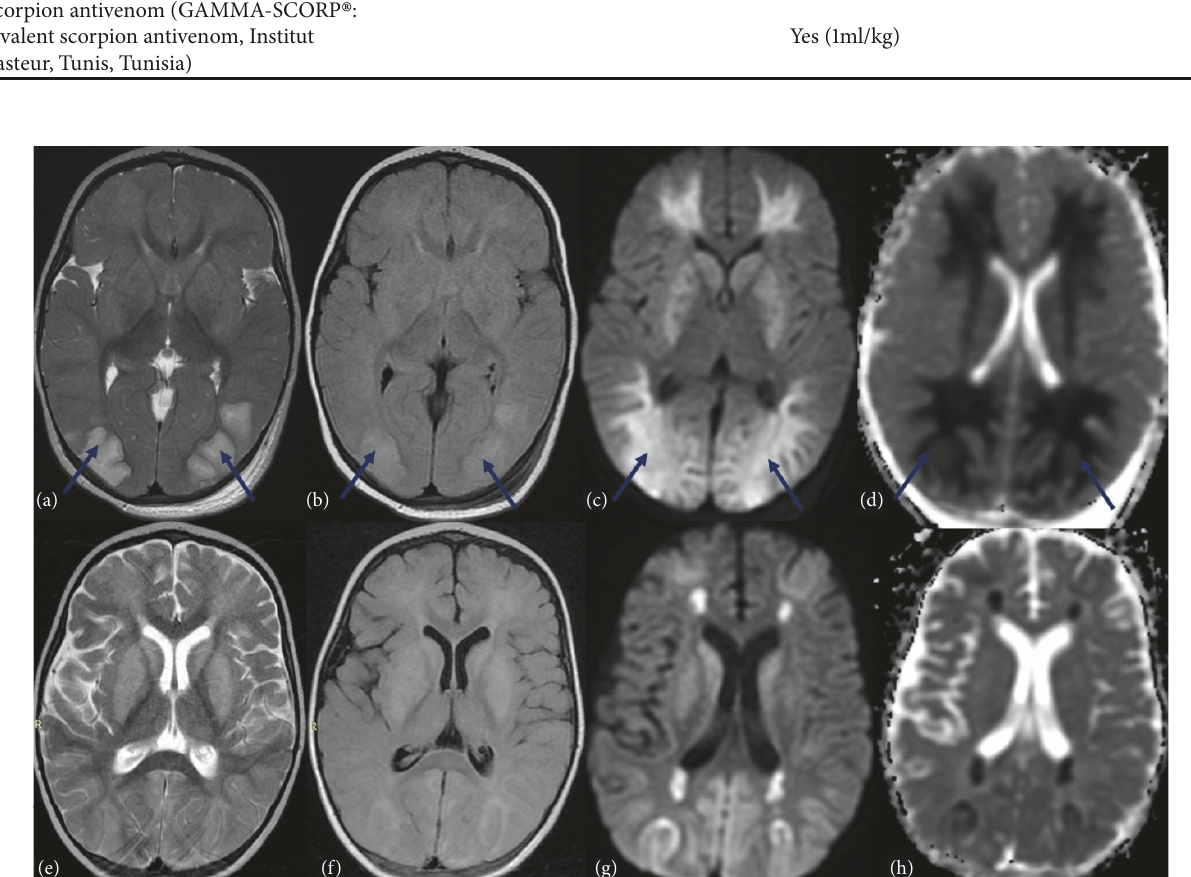
Figure 1: MRI scans: (a,e) T2-weighted;(b,f) Fluid AttenuatedInversion Recovery (FLAIR); (c,g) diffusion-weighted imaging; (d,h)apparent diffusion coefficient (ADC) map. The first MRI imaging (a,b,c,d) showed bilateral and symmetrical hyperintensity ( ) inT2, FLAIR and diffusion of the occipital and frontal lobes, cerebellar hemispheres, periventricular white matter, and basal ganglia with low ADC related to cytotoxic edema. After 9 days, control MRI (e, f, g, h) highlighted progressive volume loss of cerebrum with decreased hypersignal and increasedADC in cerebellarhemispheres,fontal and occipital lobes. Hypersignal persistsin T2, FLAIR, and diffusion in periventricularwhite matter with ADC restriction and in basal ganglia without ADC